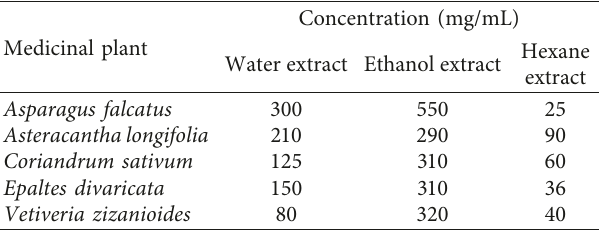
Table 5: MIC values of plant extracts against S. aureus .